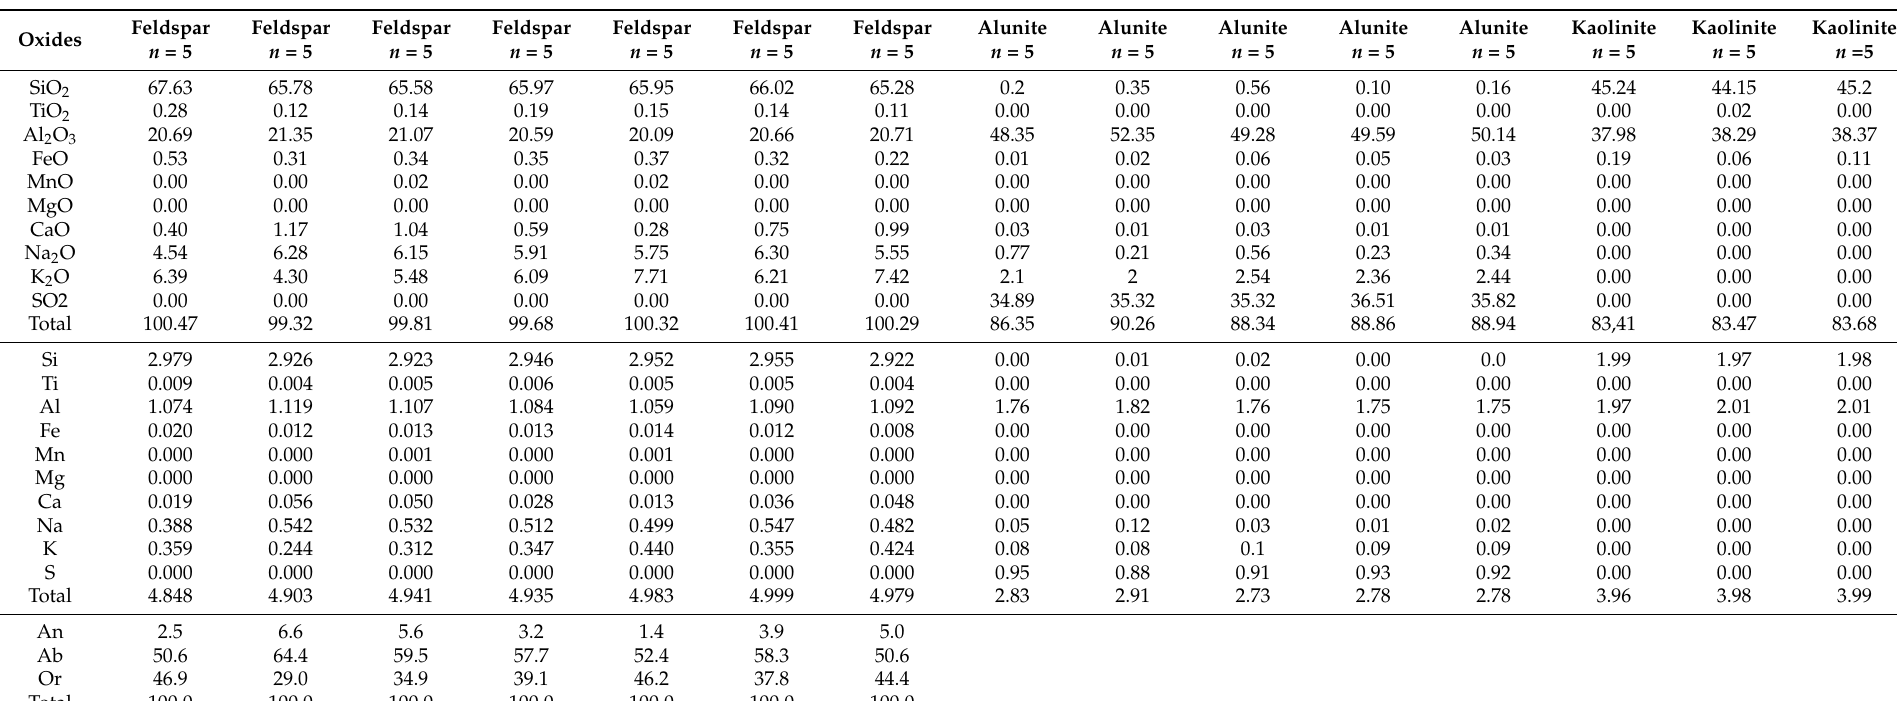
Table 2. Electron microprobe analysis of sanidine, alunite and kaolinite (n: number of